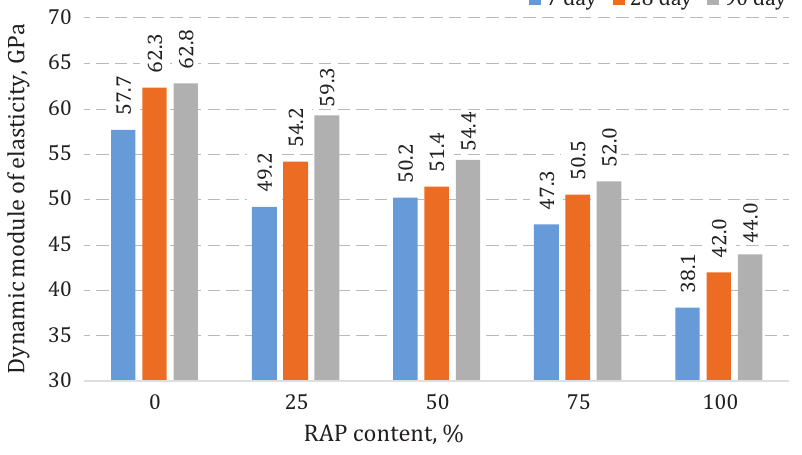
Figure 11. Dynamic modulus of elasticity of mixtures containing different